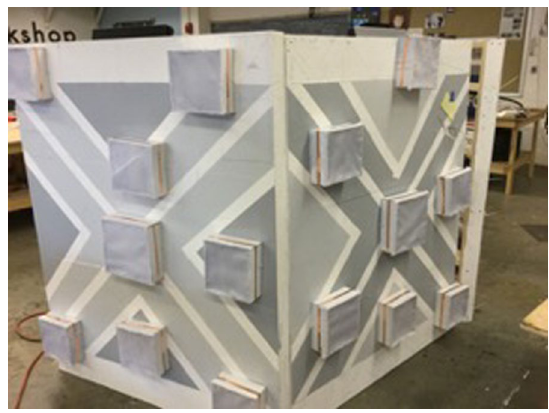
Fig. 2 Frankenstein interactive art installation consisting of three large panels adorned with boxes that emit light and sound when the user places their hand on